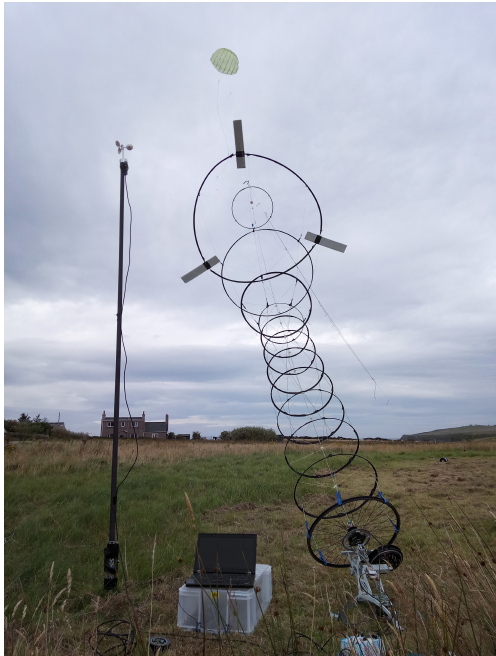
Figure 8. Image of a rigid rotor Daisy Kite prototype undergoing field tests (August